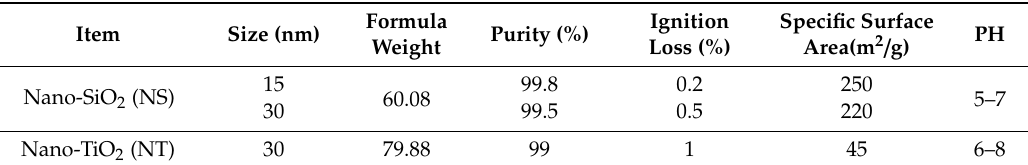
Table 3. The properties of